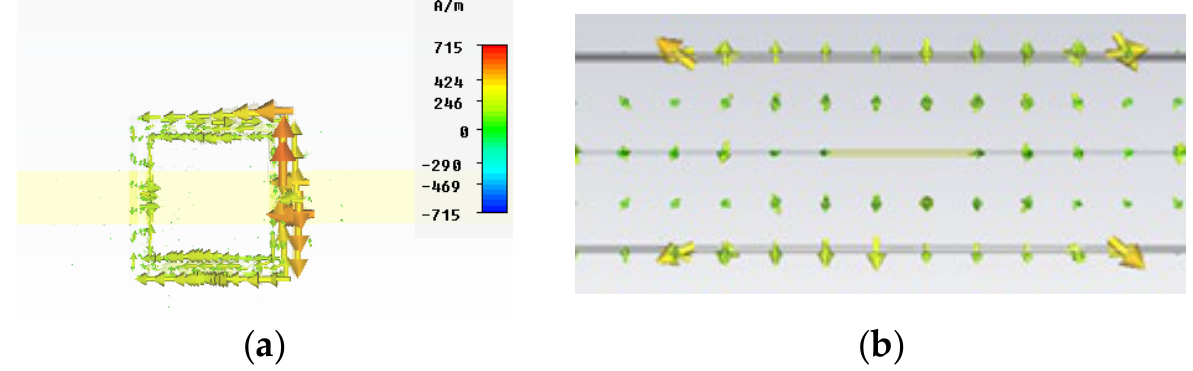
Figure 3. Vector surface current at a resonant frequency. ( a ) Absolute amplitude values (top view). ( b ) Vector values (front view).